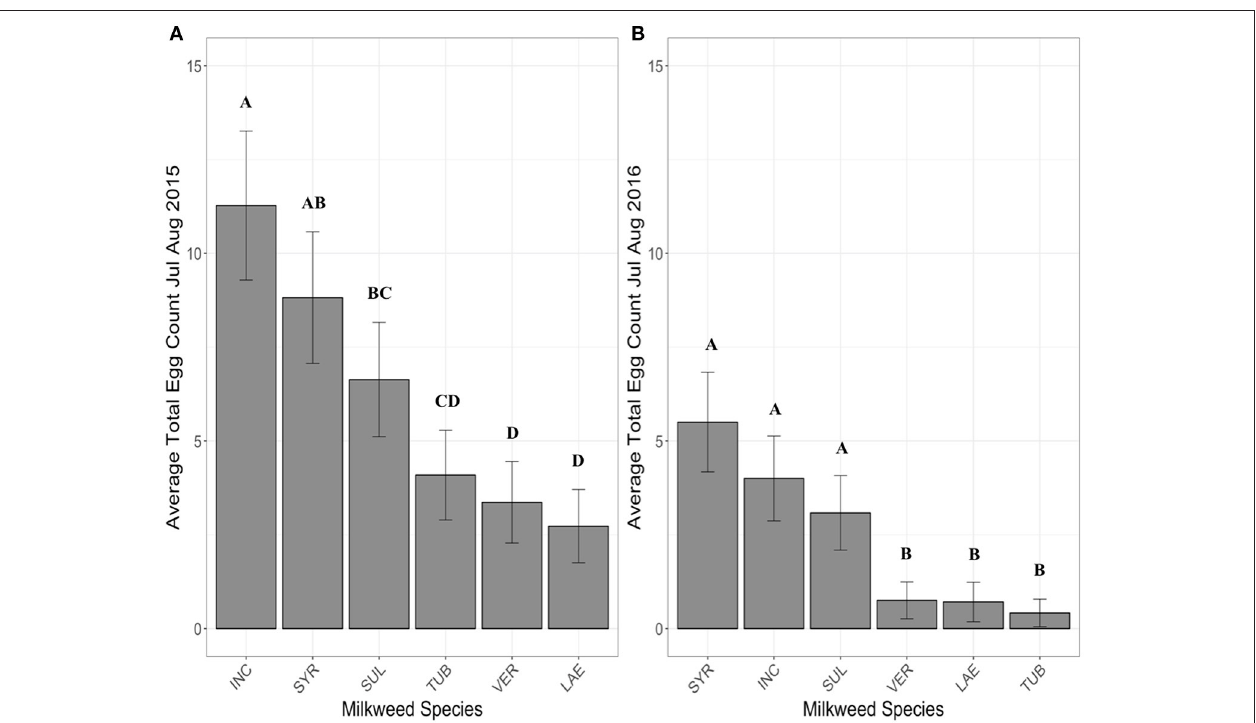
FIGURE 3 | Average eggs counted on each milkweed species in July and August in 2015 (A) , 2016 (B) when 5 plants of each species were present in each research plot. Each bar represents one milkweed species. INC, A. incarnata ; LAE, C. leave ; SUL, A. sullivantii ; SYR, A. syriaca ; TUB, A. tuberosa ; VER, A. verticillata; error bars represent 95% confidence intervals. N = 11 sites in 2015, and 12 sites in 2016. Bars that share a letter within each panel are not significantly different from each other. Females laid more eggs on A. incarnata than on A. exaltata, C. laeve, A. tuberosa, and A. verticillata in all years ( p < 0.05). The number of eggs laid on A. syriaca was not significantly different from A. incarnata . P -values were adjusted using the Tukey method for multiple